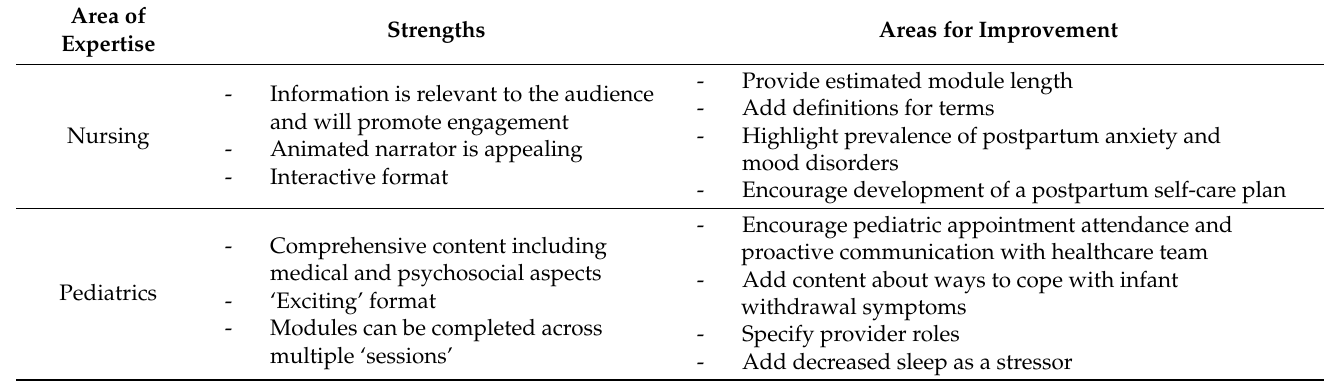
Table 1. Expert panel feedback for Project BETTER’s novel technology-delivered intervention ( N =